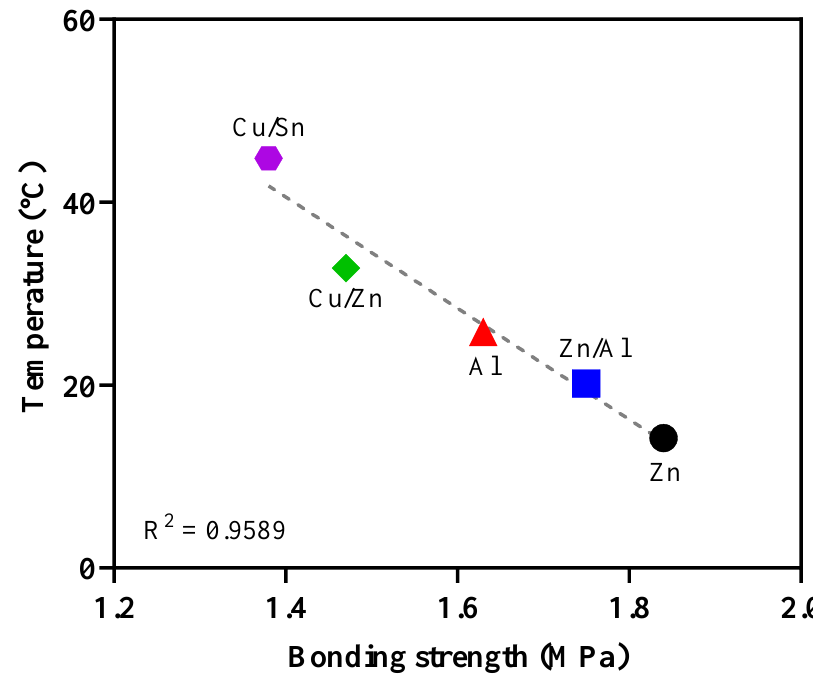
Figure 11. Relationship between the bonding strength and surface temperature.